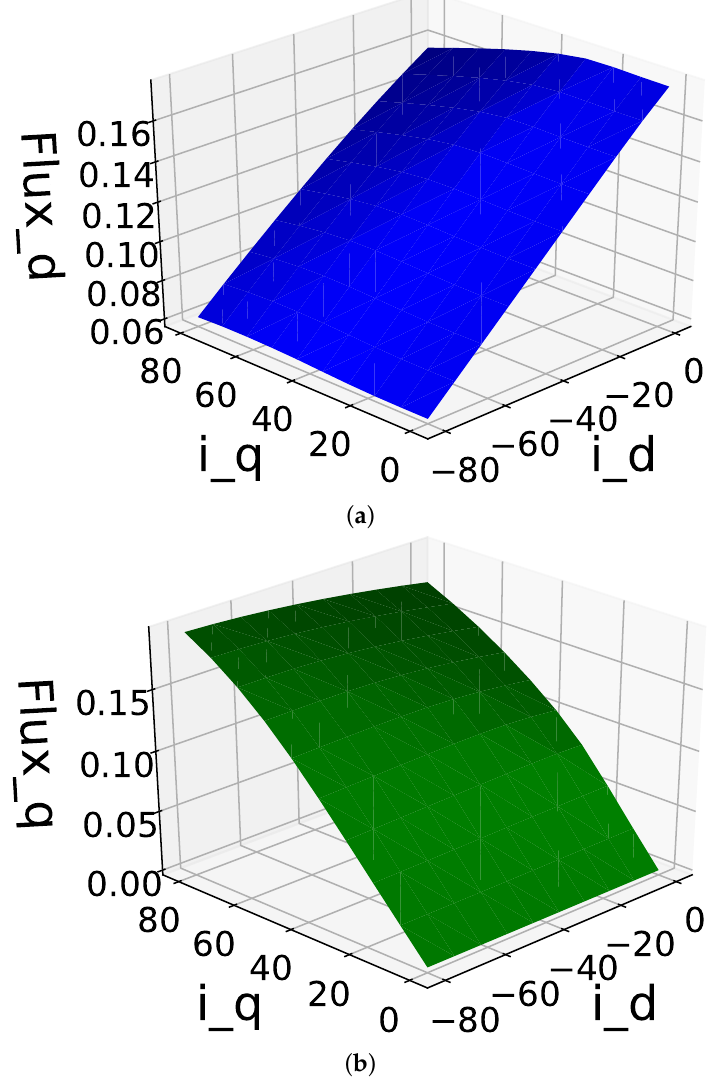
Figure 11. Flux-linkage maps with dq-axis currents ( a ) d -axis flux-linkage ( b ) q -axis